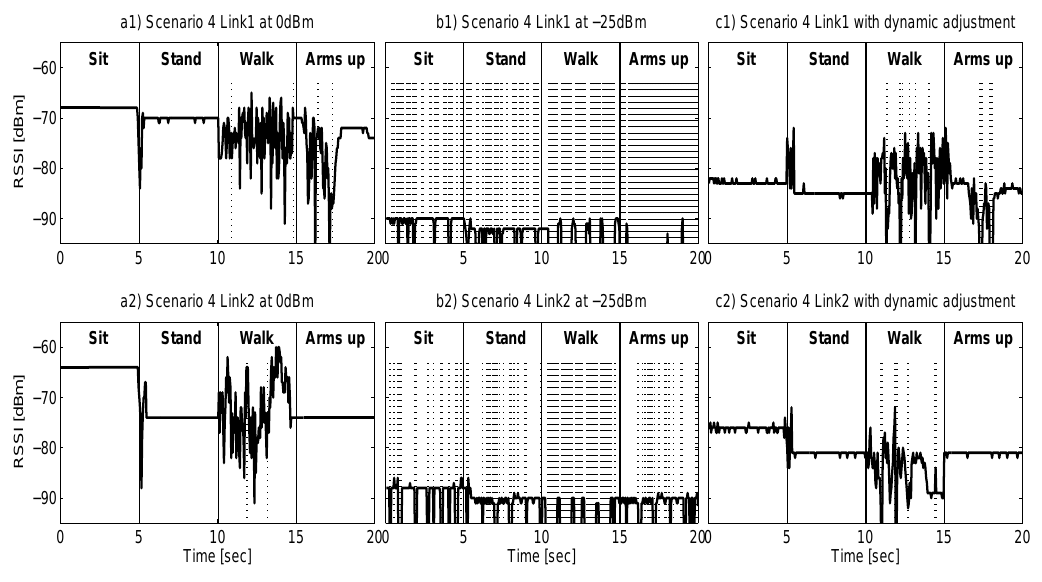
Figure 12. RSSI evolution for Shimmer in Scenario